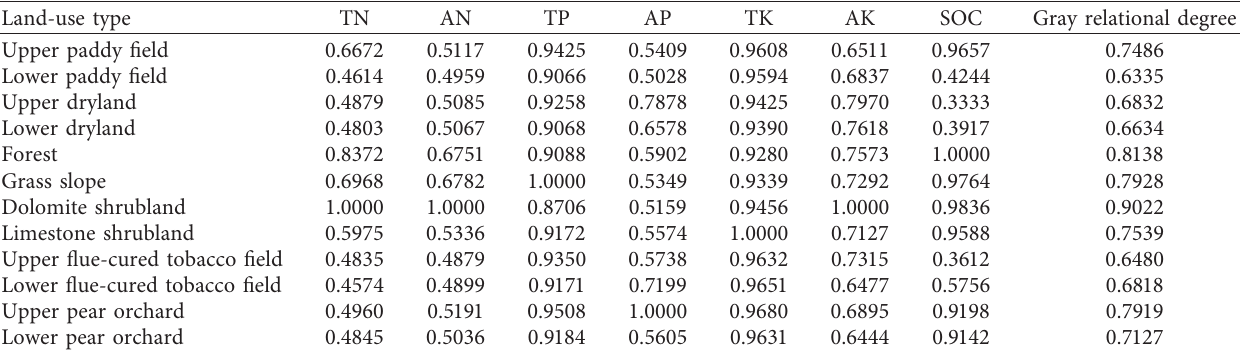
Table 3: Gray correlation coefficients and correlation degrees of soil nutrient contents under different land-use